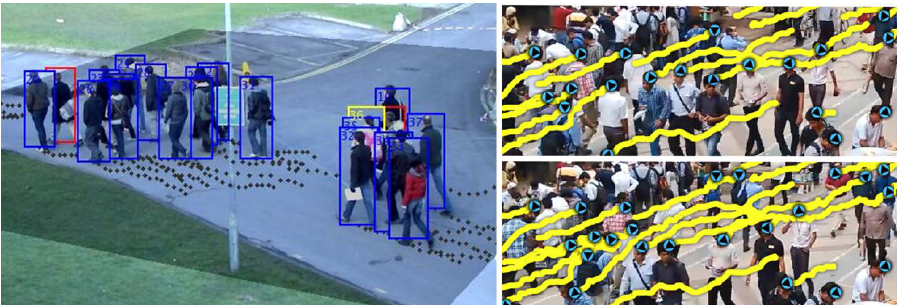
Figure 5. Smart video surveillance.